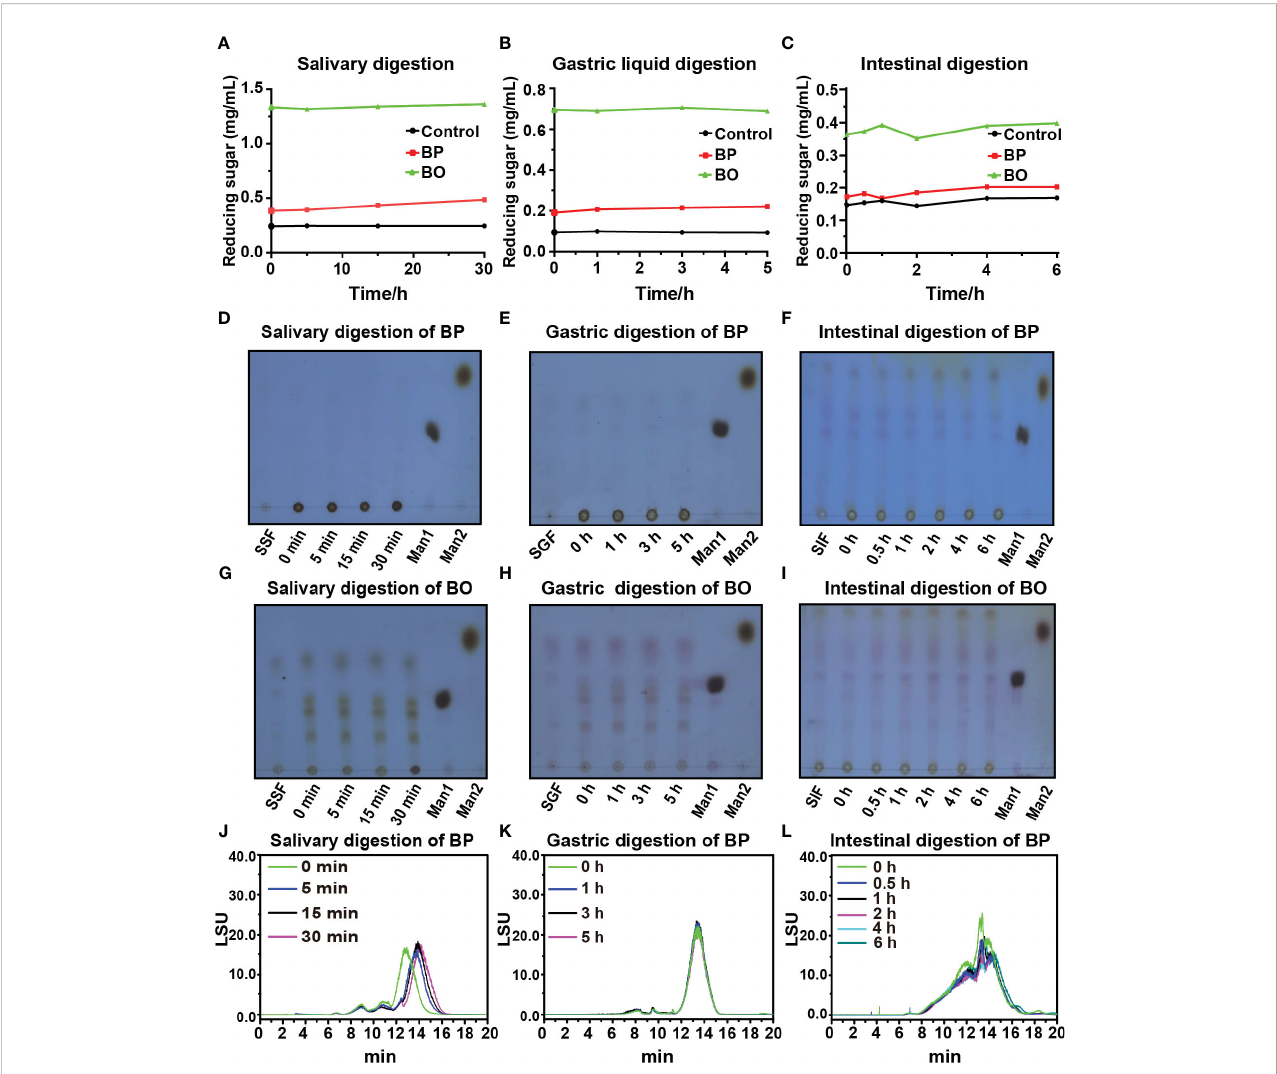
FIGURE 1 Changes in reducing sugar content and molecular weight of BP and BO during simulated saliva and gastrointestinal digestion. (A − C) Changes in reducing sugar content of BP and BO in simulated saliva and gastrointestinal digestion at different time points. (D − F) Thin layer chromatography (TLC) assay of BP that exhibited the changed molecular weights during simulated saliva and gastrointestinal digestion. (G − I) TLC assay of BO that exhibited the changed molecular weight during simulated saliva and gastrointestinal digestion. (J − L) HPGPC analysis of BP that exhibited the changed chromatogram during simulated saliva and gastrointestinal digestion. SSF, simulated salivary fermentation; SGF, simulated gastric fermentation; SIF, simulated intestinal fermentation; Man1:D-(+)-Mannose; Man2: a -1-6-Mannobiose. Data were presented as mean ± SD (n =